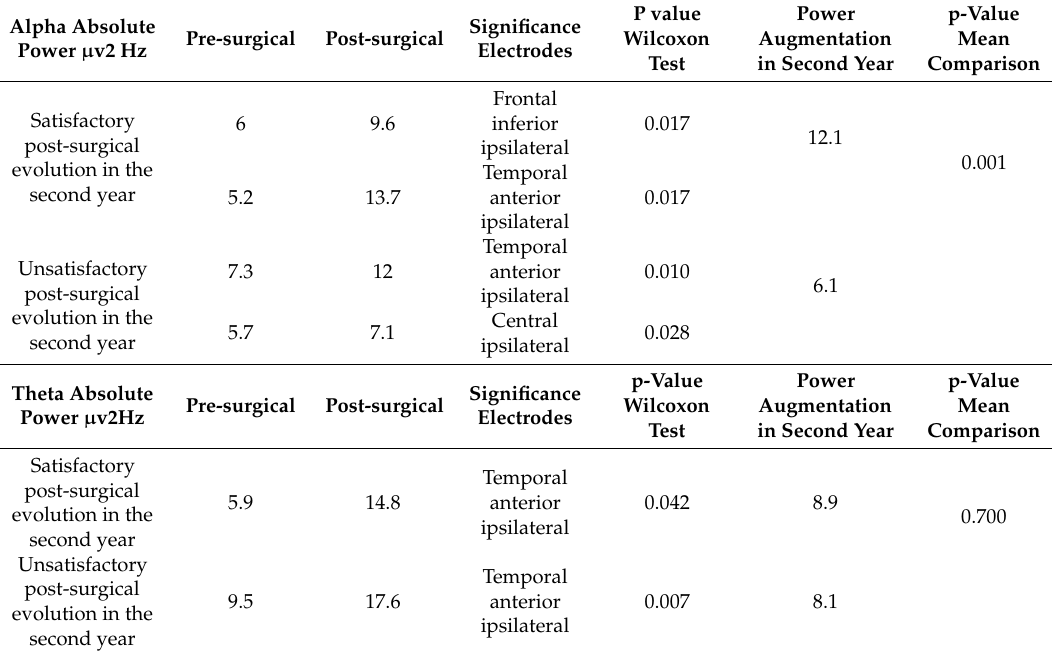
Table 2. EEG spectral frequency changes from pre-surgical to post-surgical phase. Wilcoxon test. Mean comparison, µ v2Hz (Microvolts square per